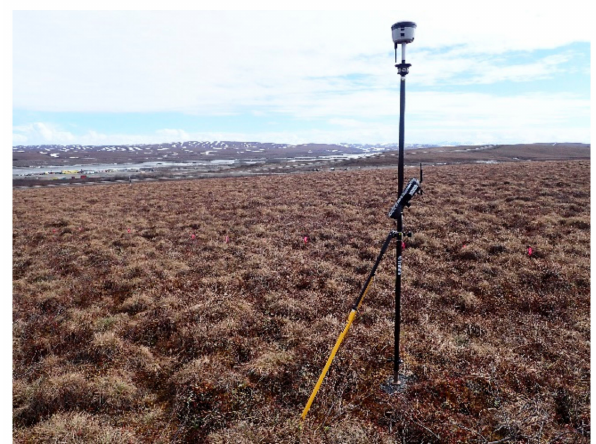
Figure A3. Field photo of HV on 31 May